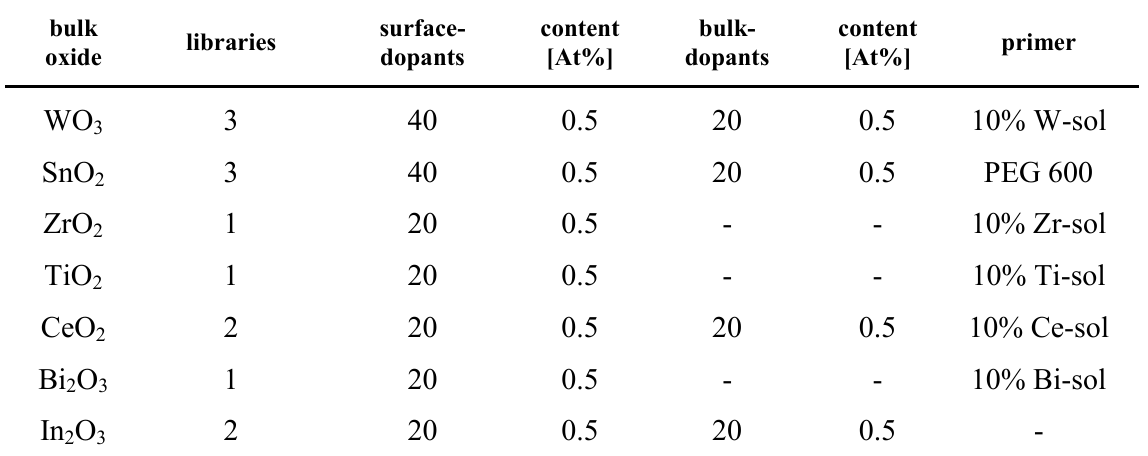
Table 2. Starting libraries, number of dopants and used primers. The amount of the bulk element in the primer sol corresponds to 10% of the amount in the oxide powder. Libraries are containing bulk- and/or surface dopants.